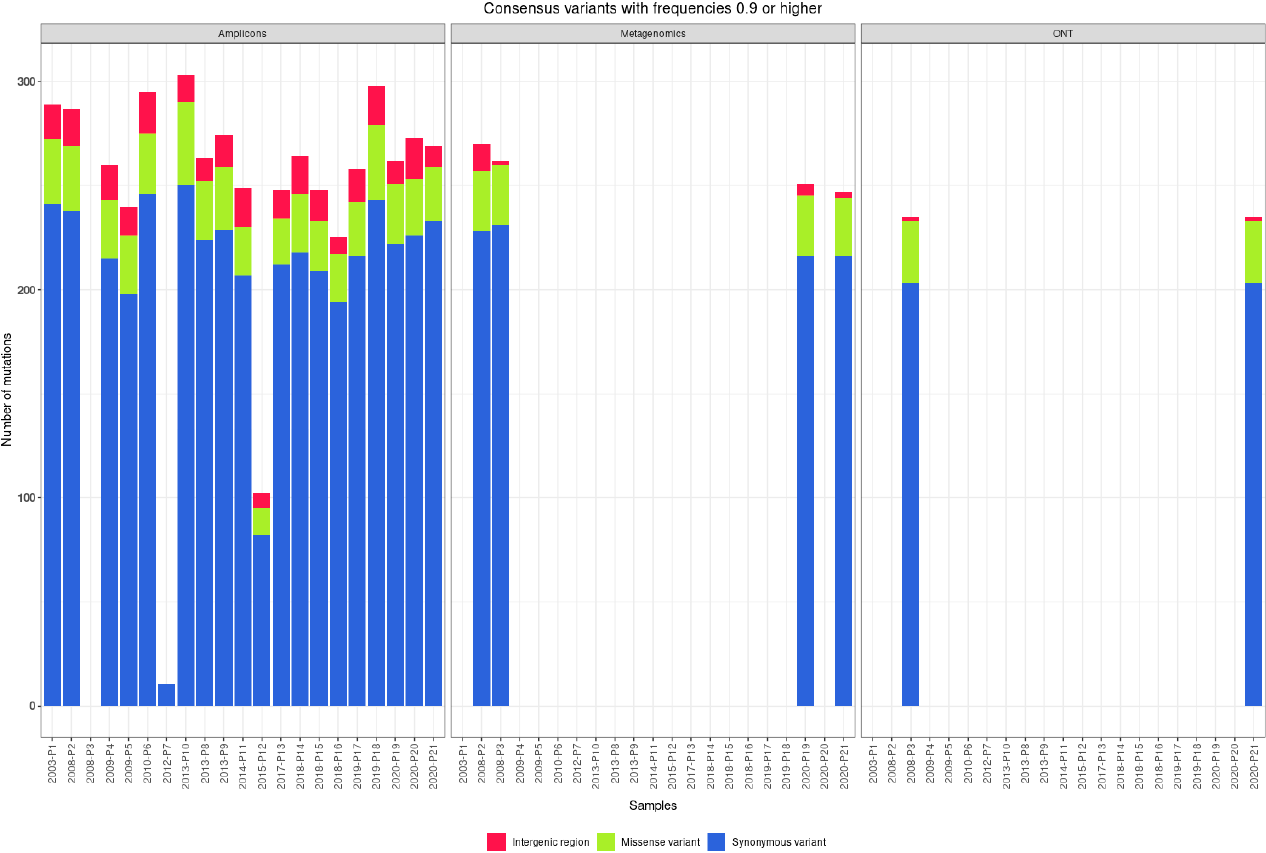
Figure 2. Number and distinct types of mutations found in sequenced TBEV genomes with amplicon-based and shotgun metagenomic sequencing on Illumina and ONT platforms.